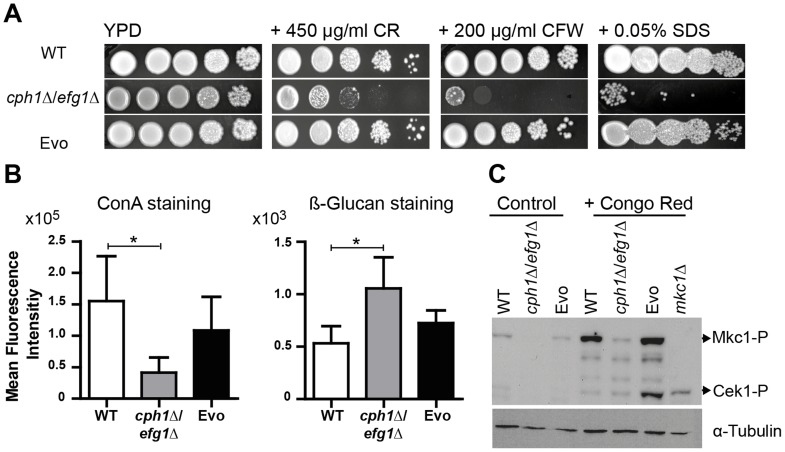
Microevolution led to decreased sensitivity of the Evo strain to different cell wall perturbing agents.(A) Resistance of analyzed strains against different cell wall stressors. The cph1Δ/efg1Δ strain was sensitive to all stresses while the Evo strain regained WT resistance (representative pictures of three experiments are shown). (B) Flow cytometry analysis of mannan and β-glucan exposure on the surface of live cells. Differences in fluorescence intensity between cph1Δ/efg1Δ strain and Evo strain point to an altered cell wall composition. Mean fluorescence intensity+SD of n = 3 (*p<0.05). (C) Western blot analysis to identify phosphorylated Mkc1 and Cek1 in C. albicans strains grown under non-stress conditions (control) or conditions of cell wall stress (450 µg/ml congo red) for 4 hours. Cell wall stress triggered phosphorylation of Mkc1 and Cek1 in the Evo strain, but not in the cph1Δ/efg1Δ strain. Tubulin served as loading control.